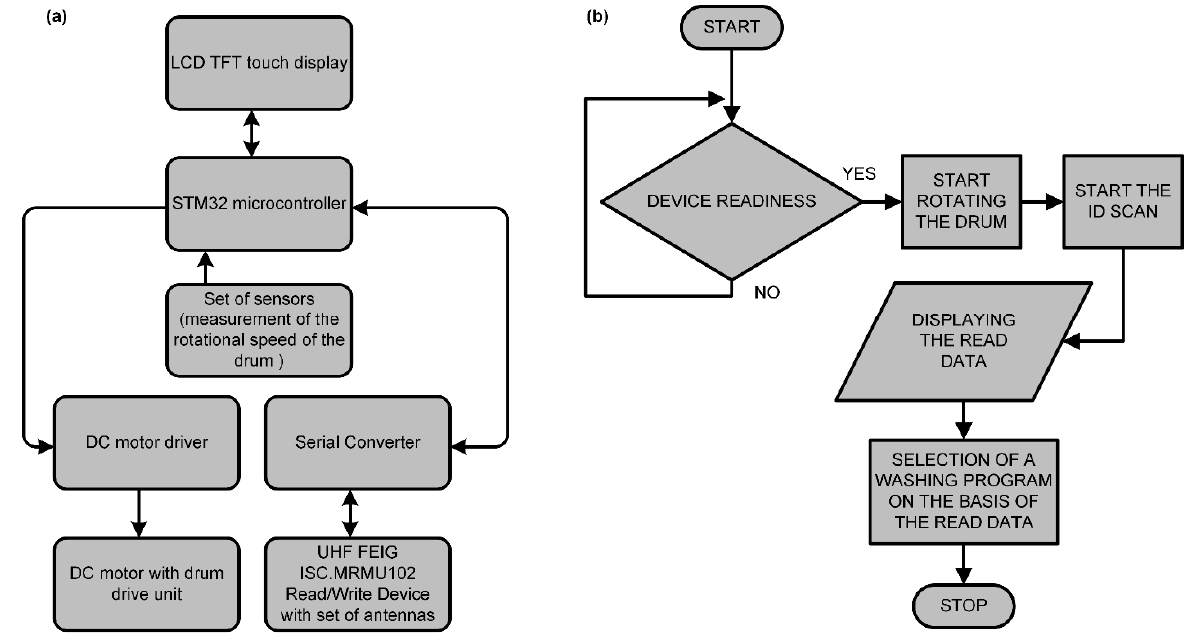
Figure 4. Simplified block diagrams of the IoTT enabled washing machine demonstrator: ( a ) electrical part; ( b ) control algorithm.